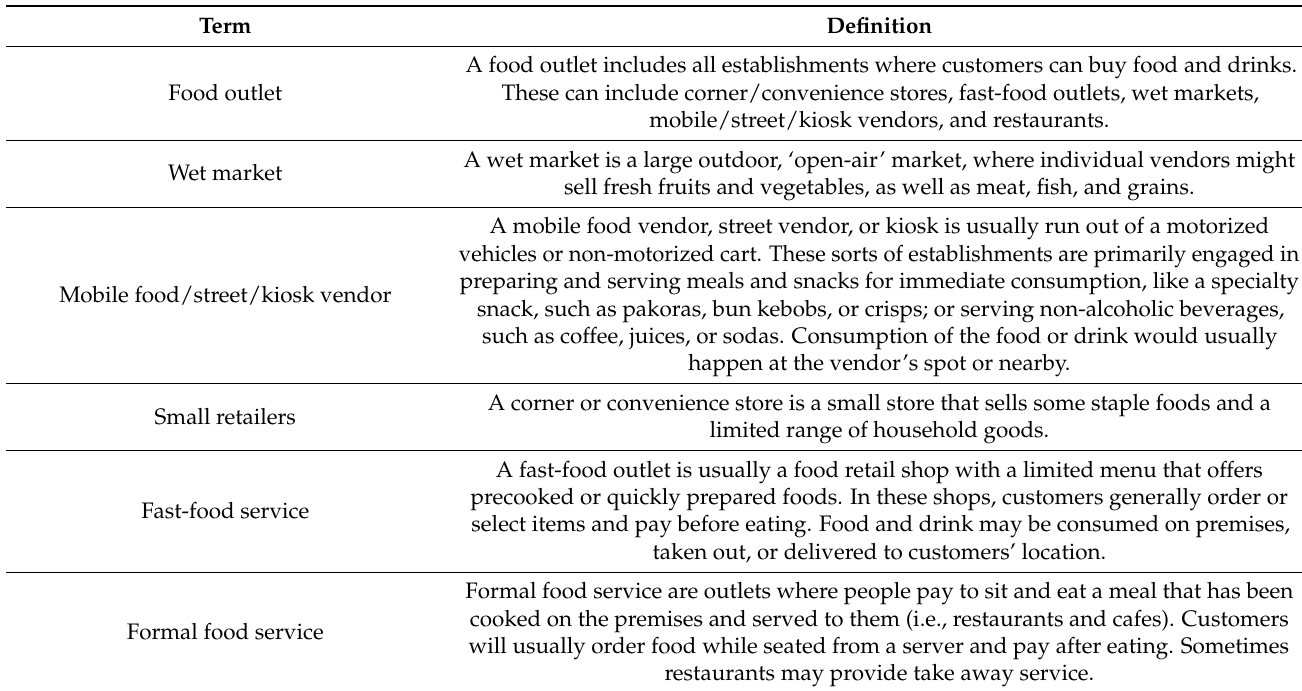
Table 1. Types of Food Outlets in Matiari, Pakistan. Adapted from